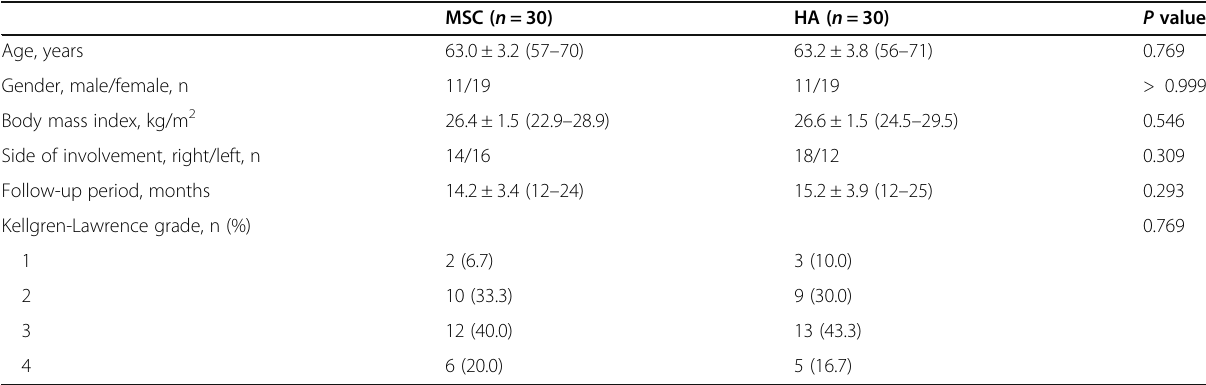
Table 1 Comparison of baseline demographics in the study